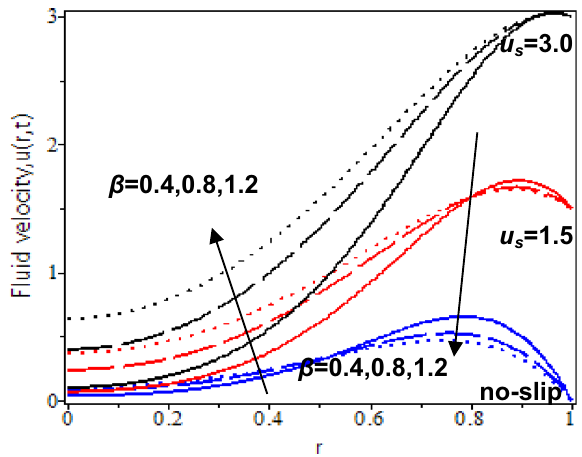
Figure 5. Nanofluid velocity with various Casson parameter and slip velocity at t = 0.5.